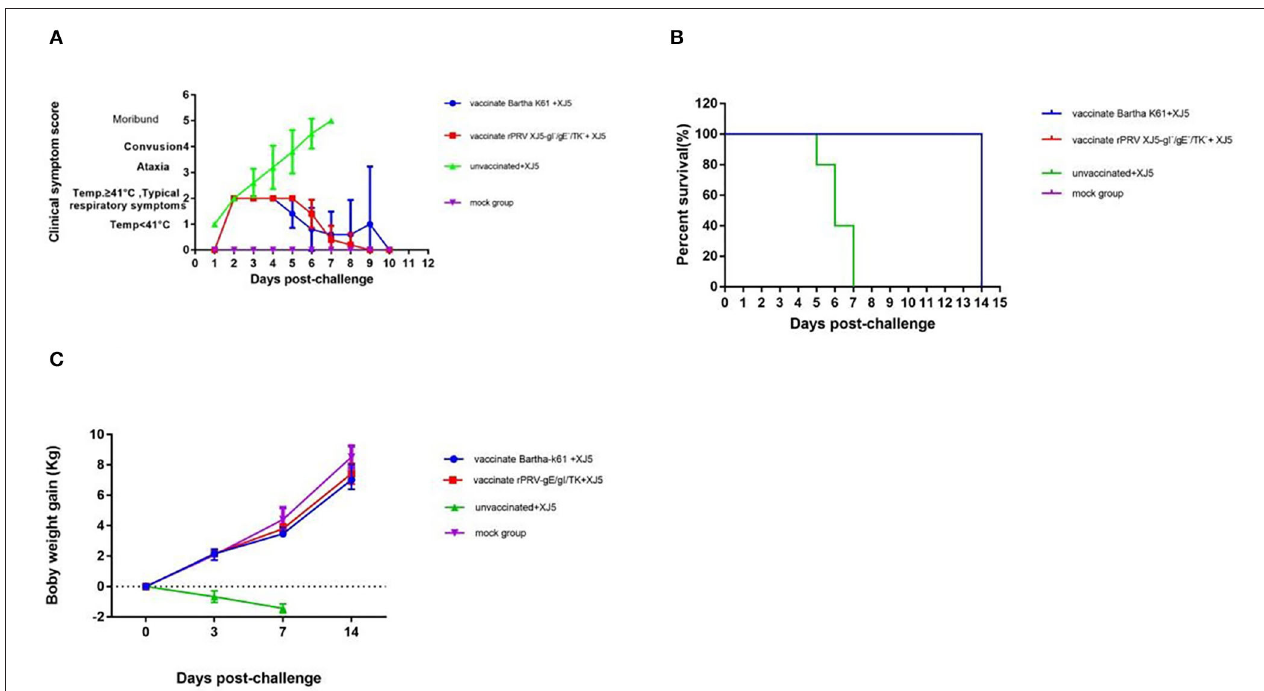
FIGURE 2 | Clinical Symptoms and weight gain After Challenge. Clinical scores (A) , survival rate (B) and weight gain in different groups (C) (error bars represent standard errors of the mean of five replicates).